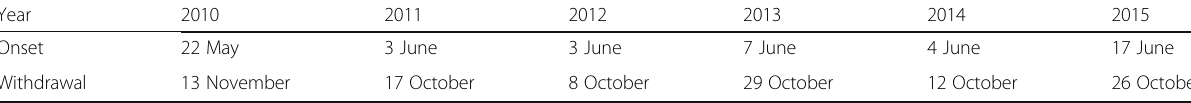
Table 2 Onset and withdrawal dates of the ASM defined for each year in 2010 –